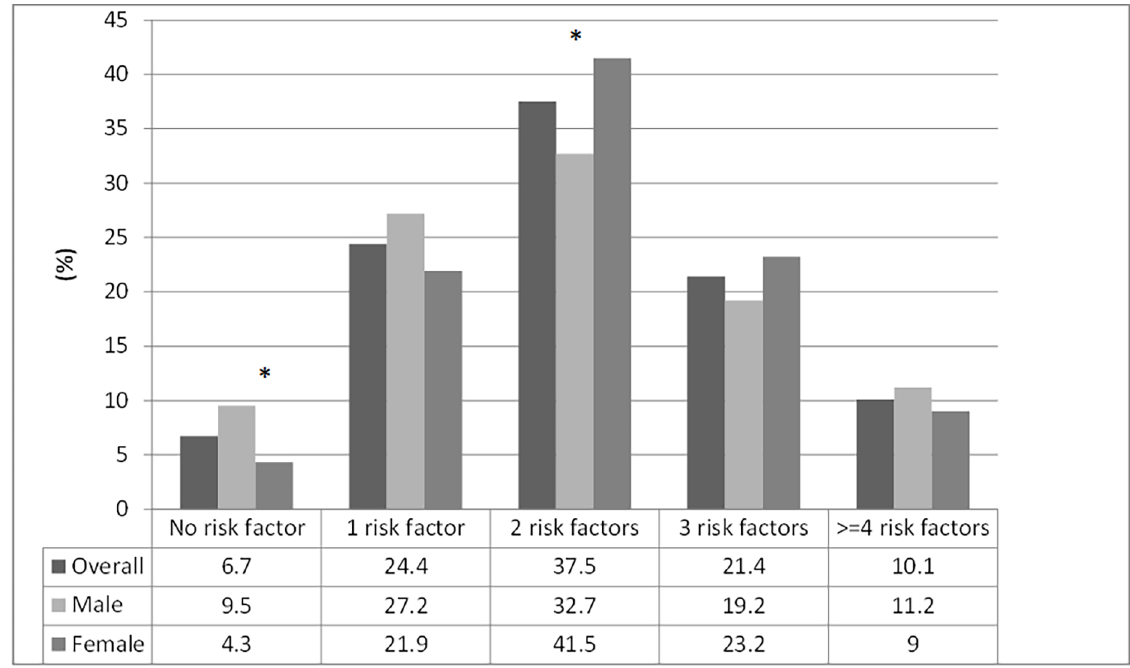
Fig 1. Sample distribution by number of cardiovascular risk factors a (n = 1025). a. Hypertension—Office blood pressure (cid:21) 95 th percentile or home blood pressure (cid:21) 95 th percentile, overweight—Body mass index (cid:21) 85 th percentile; increased waist circumference—waist circumference (cid:21) 90 th percentile; smoking—smoked at least one day over the previous 30 day; alcohol consumption–alcohol consumption in the last 30 days; sedentary lifestyle—less than 300 minutes of moderate or vigorous physical activity in the last week; family history of cardiovascular disease. (cid:3) Difference between male and female—Statistically significant at α = 0.05.